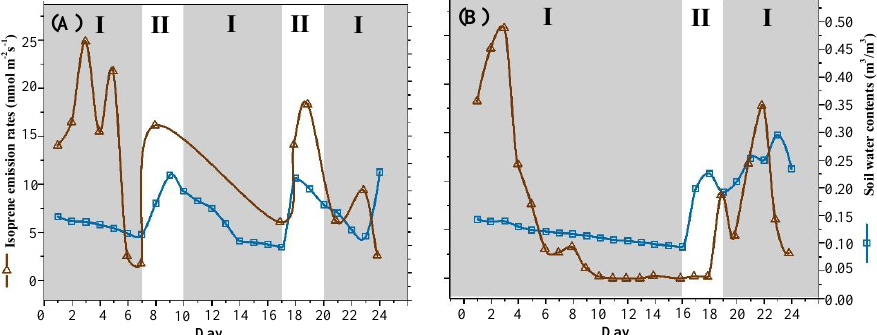
Figure 1. SWC and isoprene emission rates in drought–rehydration cycles of different drought durations. ( A ). SWC and isoprene emission rates in a drought-rehydration cycle of short drought duration. ( B ). SWC and isoprene emission rates in a drought-rehydration cycle of long drought duration. ‘I’ represents the drought period; “II” represents the rehydration period. (Note, The F iso data of short drought durations in D9-D15, and D20 was lost.)